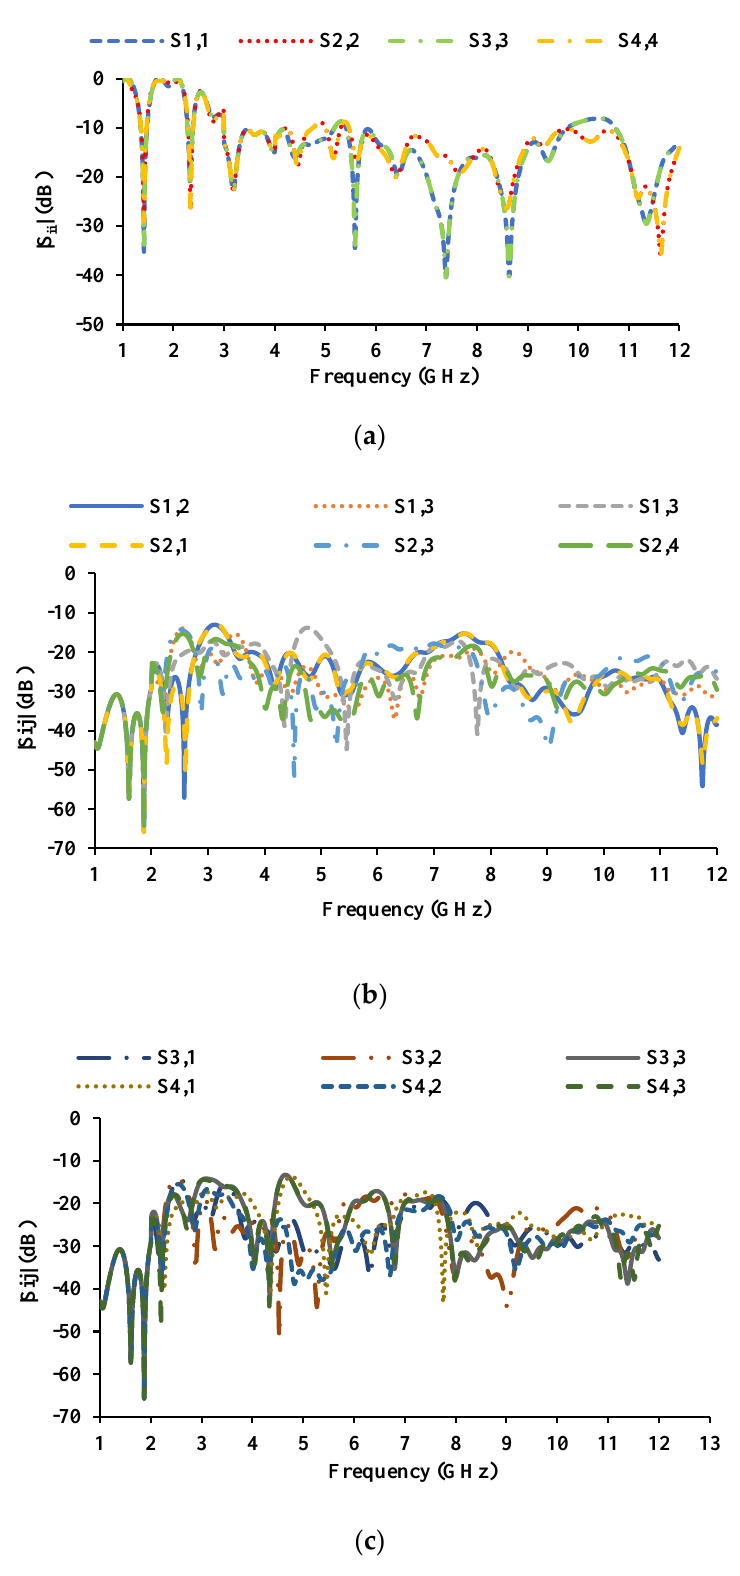
Figure 10. S-parameters of the MIMO antenna with the connected ground plane: ( a ) reflection coefficients, ( b ) mutual coupling with respect to port 1 and port 2, ( c ) mutual coupling with respect to port 3 and port 4.